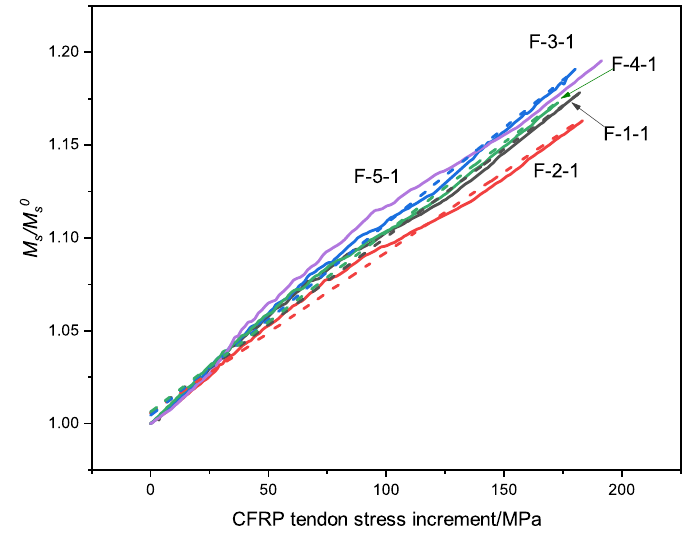
Figure 11. The curve of the secondary bending moment and stress increment.